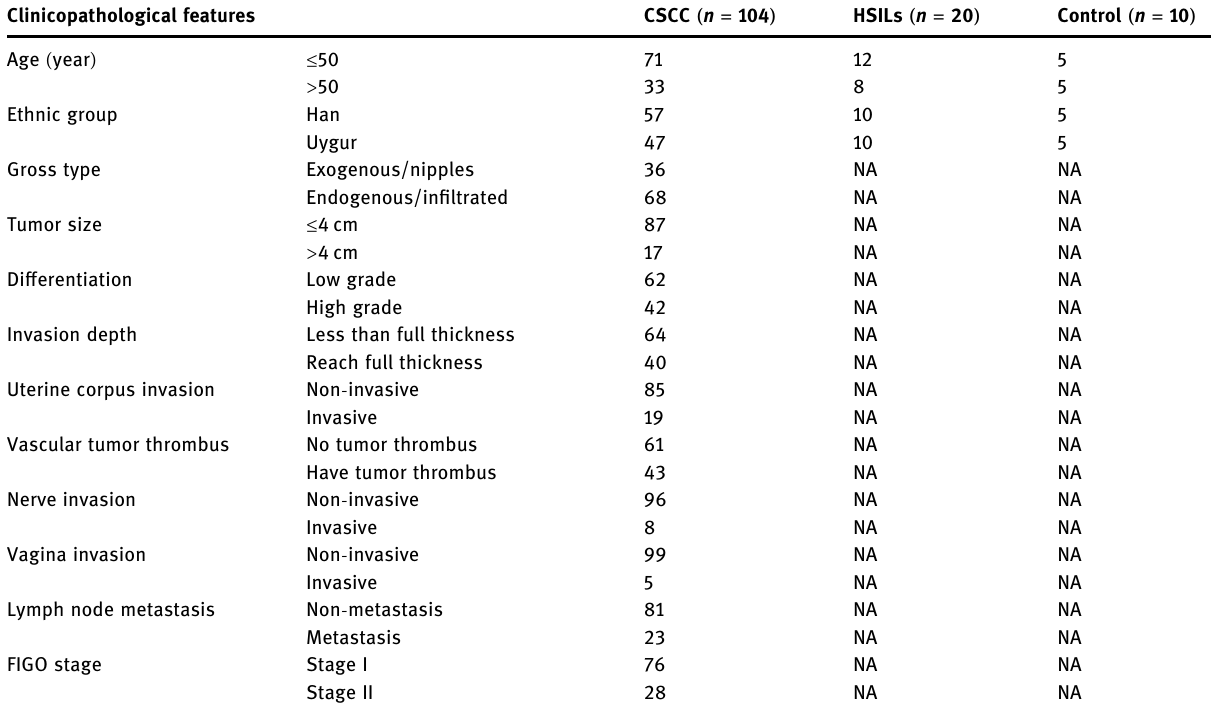
Table 1: Clinicopathological characteristics of subjects included in the study Clinicopathological